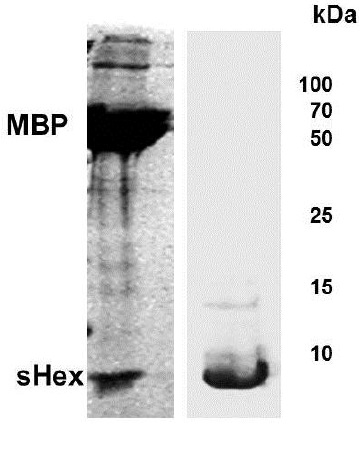
Figure 5. Expression and purification of Hex polypeptide. Full length hex gene